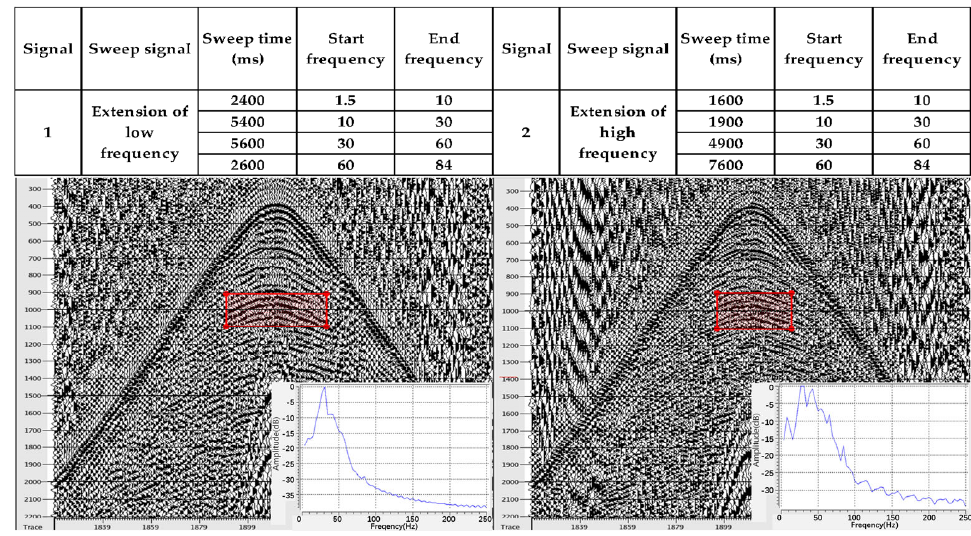
Figure 6. Comparison of the nonlinear vibroseis sweep signal test records.